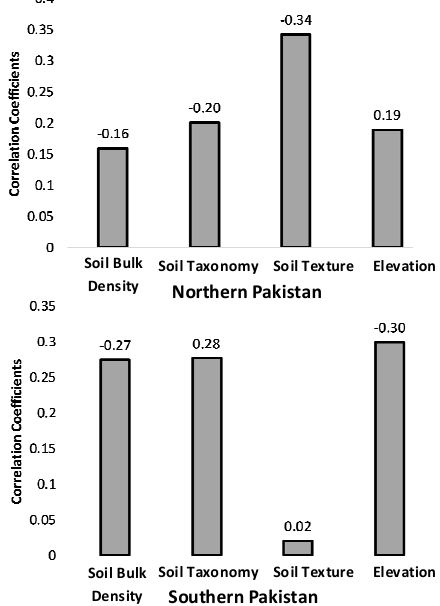
Figure 8. Pear son’s Temporal in Northern Pakistan (top panel) and Southern Pakistan (bottom panel), R of monthly FC in logarithm versus mean soil properties, elevation. R was calculated at monthly scales using data from 2001 to 2020.